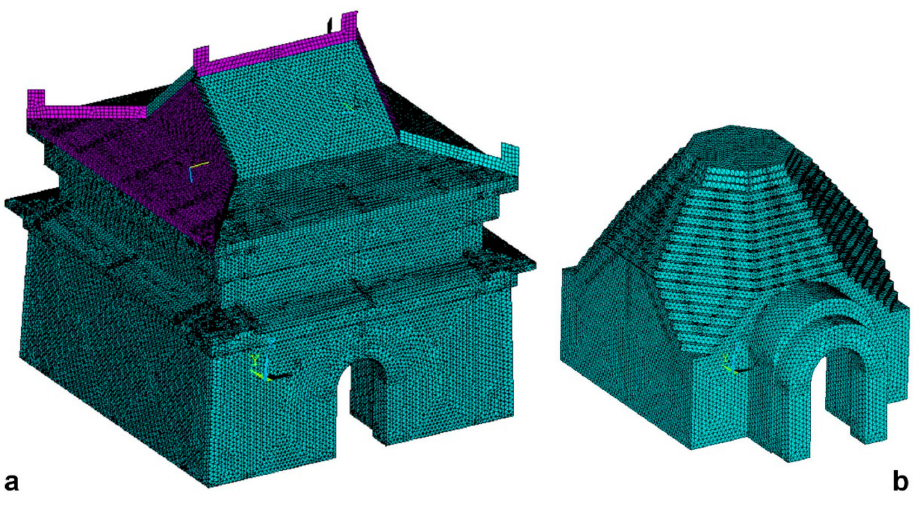
Figure 14. Finite element model of limestone hall established in ANSYS. ( a ) Mesh diagram of external structure of limestone hall; ( b ) Mesh diagram of internal structure of Limestone